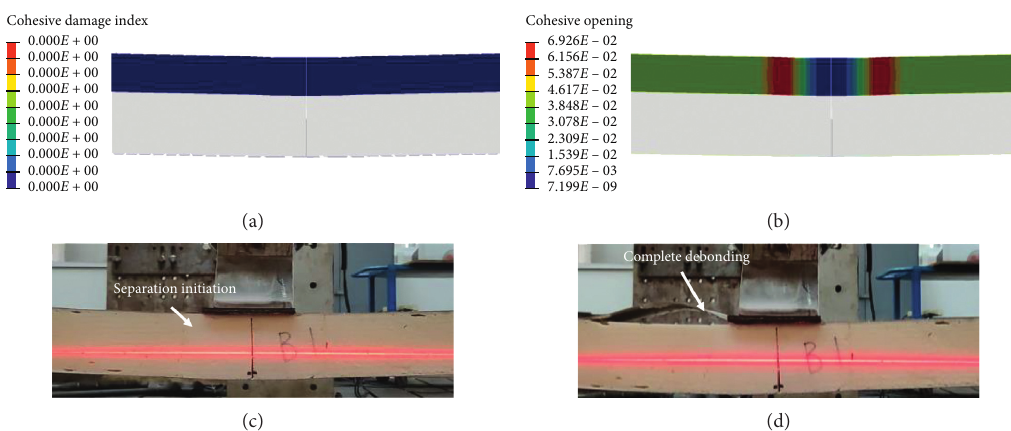
Figure 12: Damage state calculated by the deterministic model and debonding failure occurred in the experiment: (a) damage indicator, (b) cohesive opening, (c) adhesive failure initiation, and (d) adhesive complete